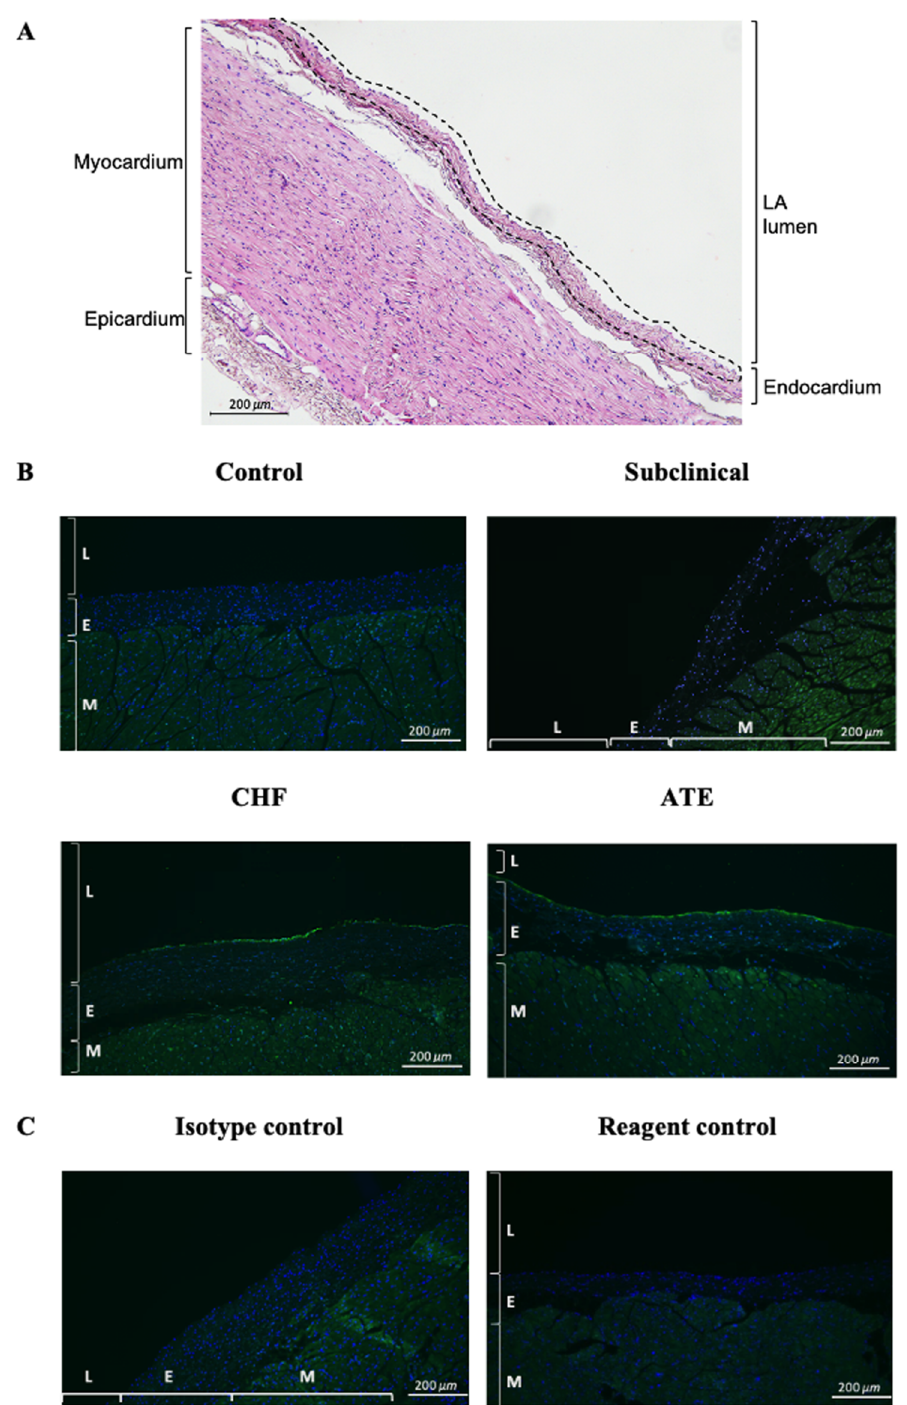
Figure 4. Comparison of the vWF immunostaining at the endocardium. ( A ) Image illustrating the LA anatomical structures and the region of interest where the intensity of immunofluorescence was quantified (dotted overlay). ( B ) Representative images showed the variation in immunolabelling of vWF (green) at the endocardium in the different groups of cats. ( C ) Isotype control immunostaining was performed using rabbit IgG. Reagent control was performed with the primary antibody omitted. 100× magnification; Bar = 100µm; LA (Left atrium), L (Lumen), E (Endocardium), M (Myocardium).